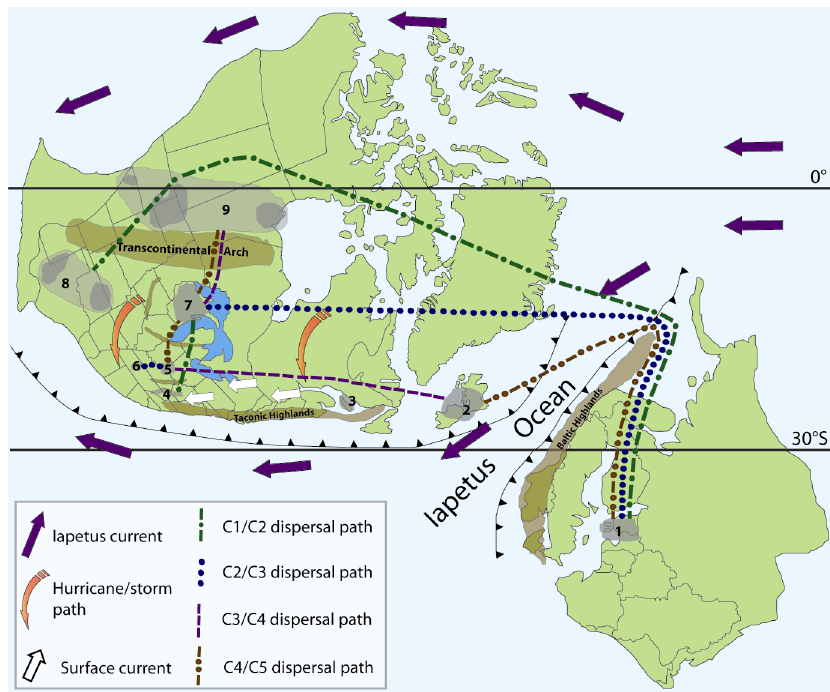
Fig. 1. Paleogeography map of Laurentia and Baltica during the Late Ordovician with inferred dispersal pathways and major paleoclimate and oceanographic influences on larval dispersal labeled. Biogeographic areas analyzed are: 1, Baltic Basin; 2, Scoto-Appalachian Basin; 3, Anticosti Island; 4, Appalachian Basin; 5, Cincinnati Basin; 6, Nashville Dome; 7, Upper Mississippi Valley; 8, Western Midcontinent (Texas and Oklahoma basins); 9, North of the Transcontinental Arch (Hudson, Williston and Bighorn basins). Paleoceanography after Cocks & Torsvik (2011); current direction and storm tracks after Poussart et al. (1999), Hermann et al. (2004) and Ettensohn